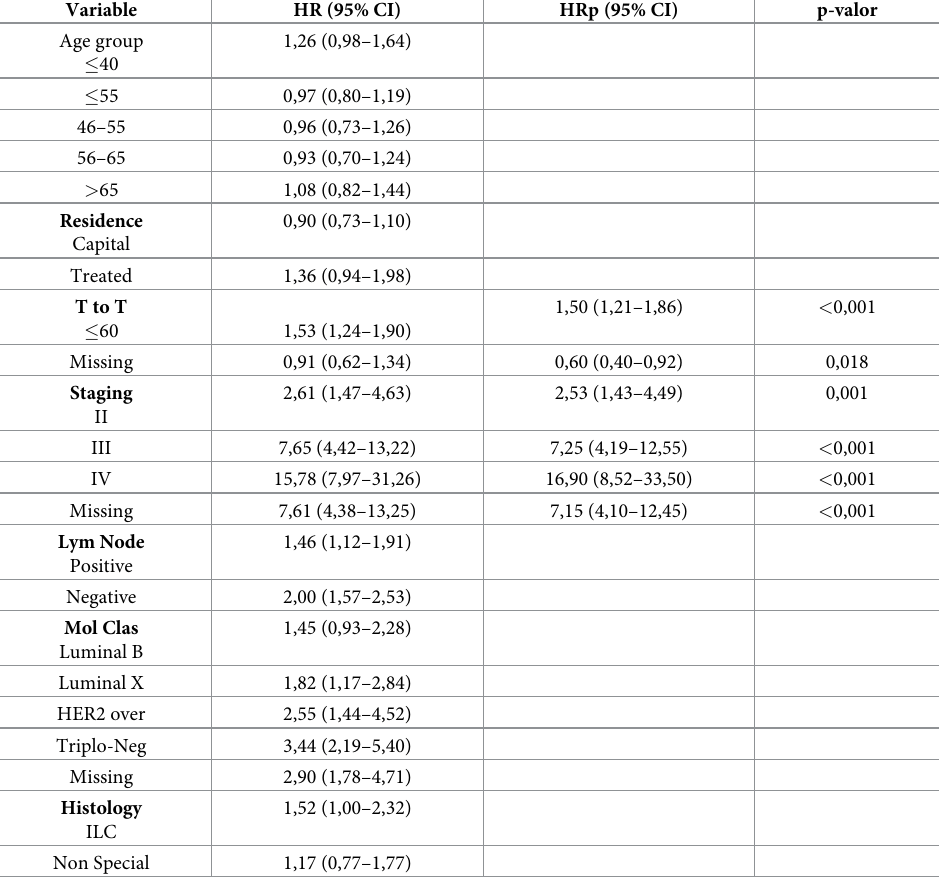
Table 3. Effect of time-dependent variables on the survival probability of patients with breast cancer using the univariate (unadjusted) and multivariate (adjusted) cox regression